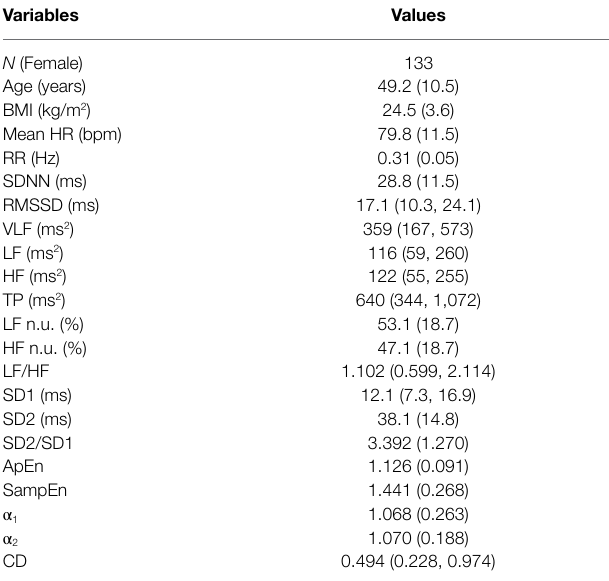
TABLE 1 | Demographics and heart rate variability (HRV) of breast tumor patients. Variables